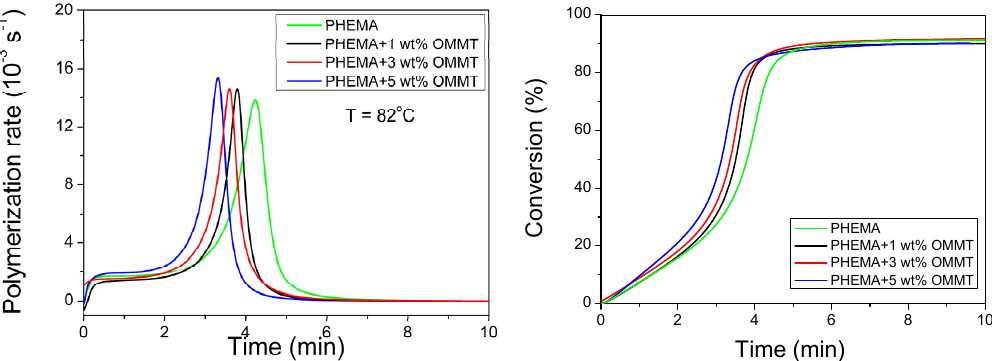
Figure 7. Effect of the amount of nano-OMMT on the variation of polymerization rate ( a ) and conversion ( b ) with time during polymerization of HEMA at 82 °C.